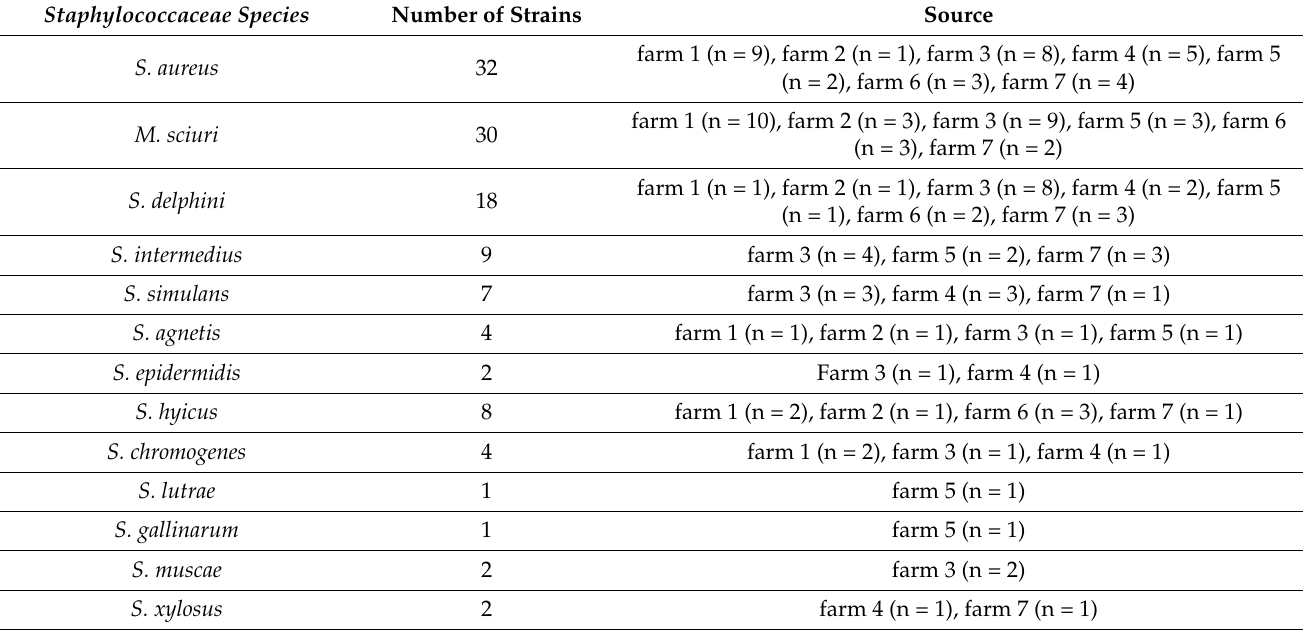
Table 1. Distribution of different camel-derived Staphylococcaceae strains in the seven